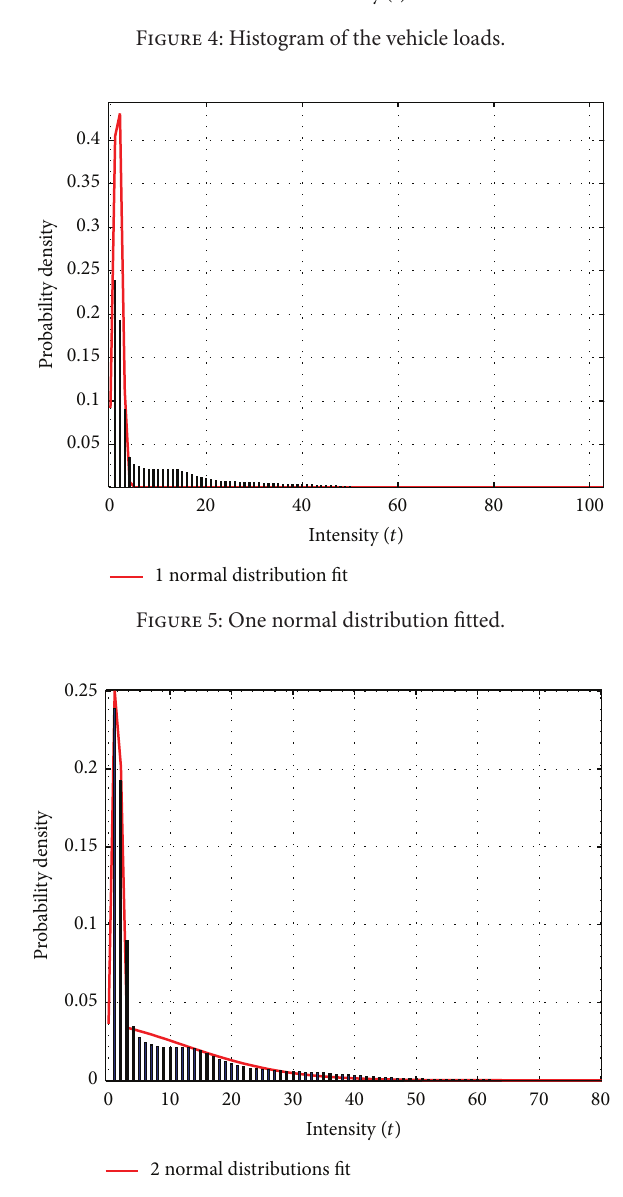
Figure 6: Two normal distributions